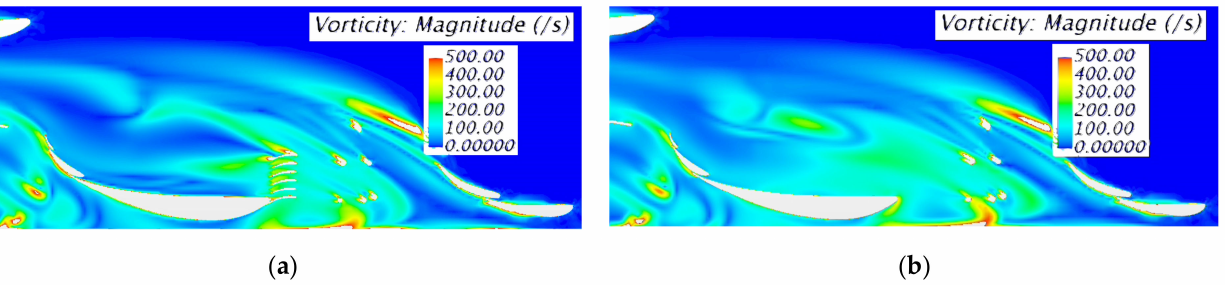
Figure 21. Comparison of vorticity at 400 mm offset section plane of vehicle longitudinal symmetrical plane. ( a ) Original condition, the vorticity above the upper surface of side wing is relatively high, that is, in a low-pressure turbulent condition; ( b ) the vorticity on the side wing upper surface is reduced significantly after implementing the shutters, indicating a transition to a more organized flow